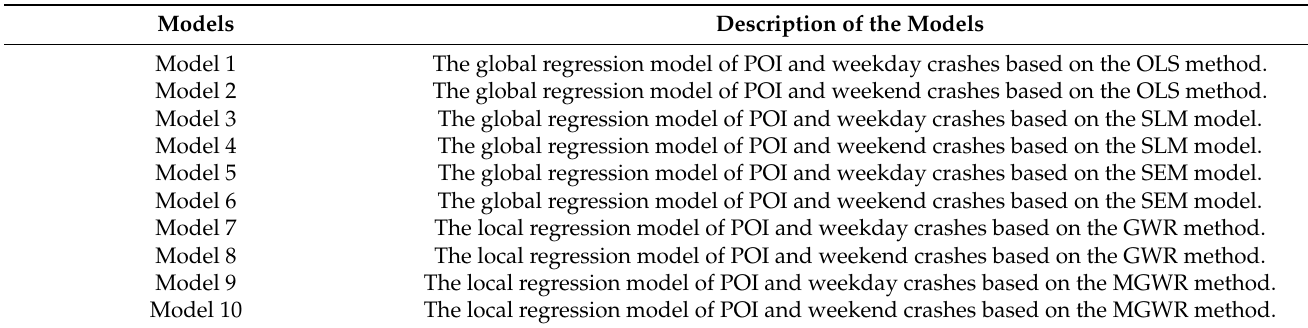
Table 3. Description of the ten regression